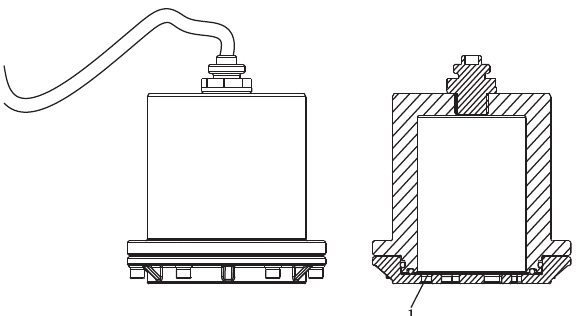
Figure 1: Enrichment filter mechanism, wherein marked 1 is the composite reverse osmosis